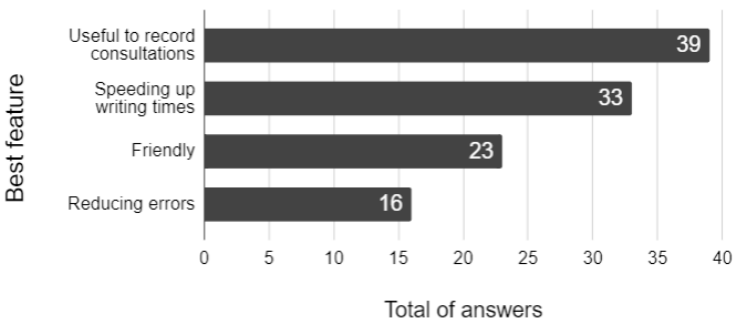
Figure 9. Best features of the proposed approach, according to the survey performed on